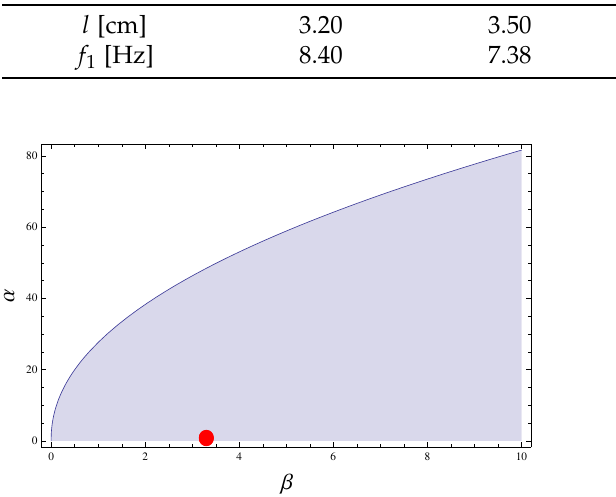
Figure 6. Domain of stability for the flapping flag marked by the shaded zone [30]. The red point represents our experimental